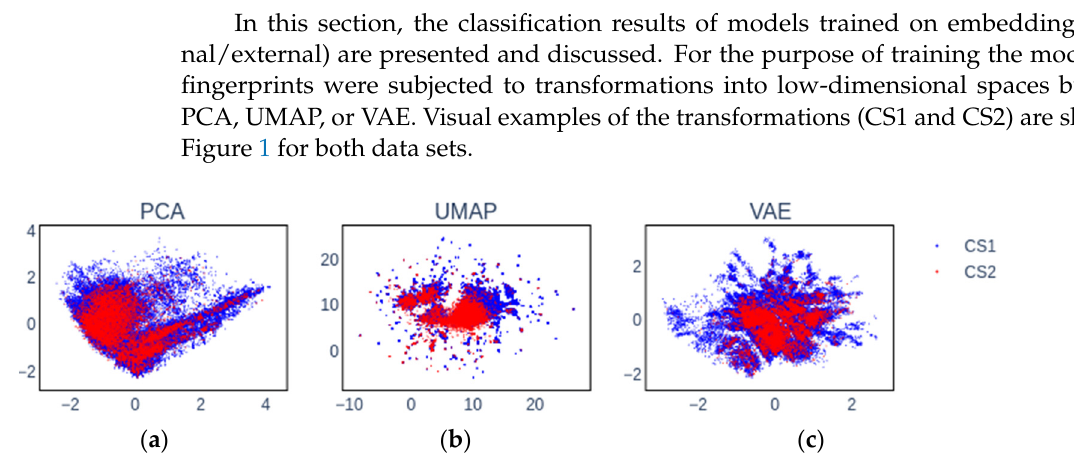
Figure 1. Exemplary visualization of CS1 (red) and CS2 (blue) show in 2D embedded space generated from molecular fingerprints by means of ( a ) principal component analysis (PCA), ( b ) uniform manifold approximation and projection (UMAP), and ( c ) variational autoencoders